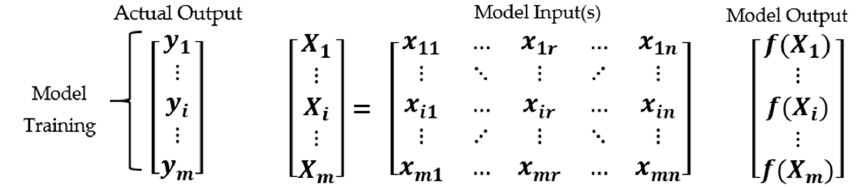
Figure 1. Schematic diagram describing structure of training data.